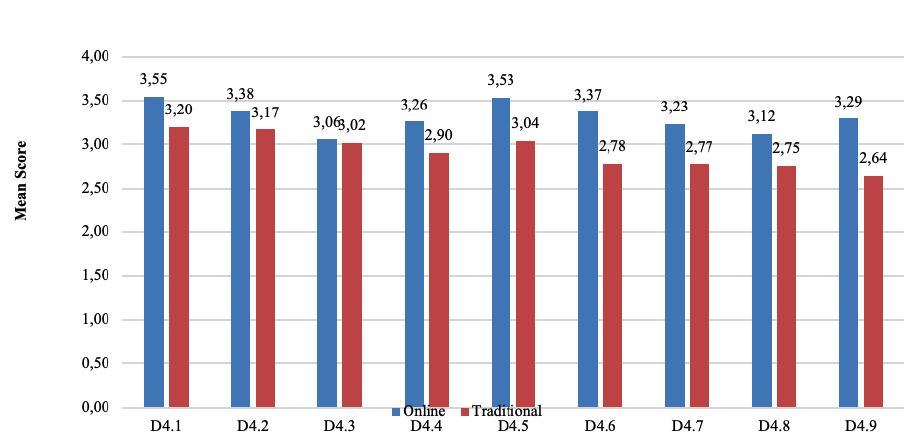
Figure 4: Effectiveness of online